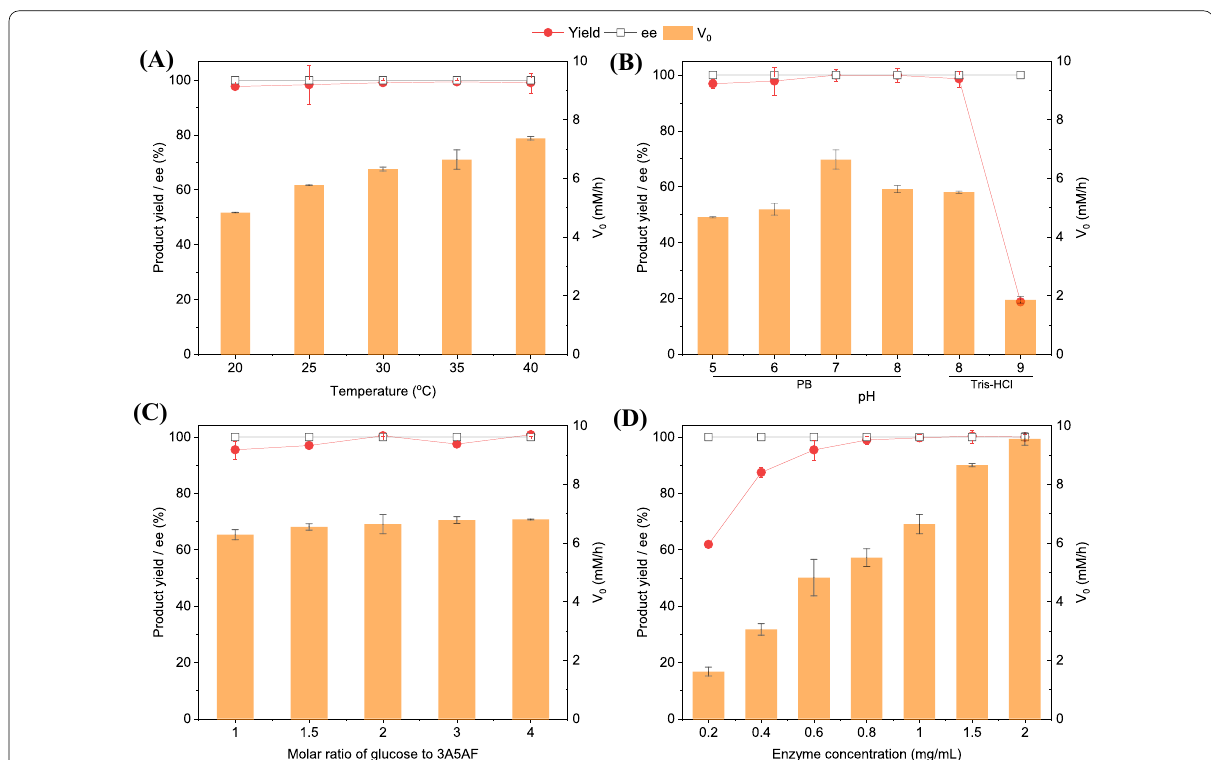
Fig. 2 Effects of temperature ( A ), pH ( B ), substrate molar ratios ( C ), and ScCR concentrations ( D ) on enzymatic synthesis of ( R )‑3A5HEF. General reaction conditions: 10 mM 3A5AF, 1 mg/mL ScCR, 0.05 mg/mL GDH cell‑free extract, Mol glucose : Mol 3A5AF phosphate buffer (0.1 M, pH 7) containing 5% DMSO (v/v), 35 °C, 150 r/min, 7 h; A 20–40 °C; B pH 5–9; C 1–4; D 0.2–2